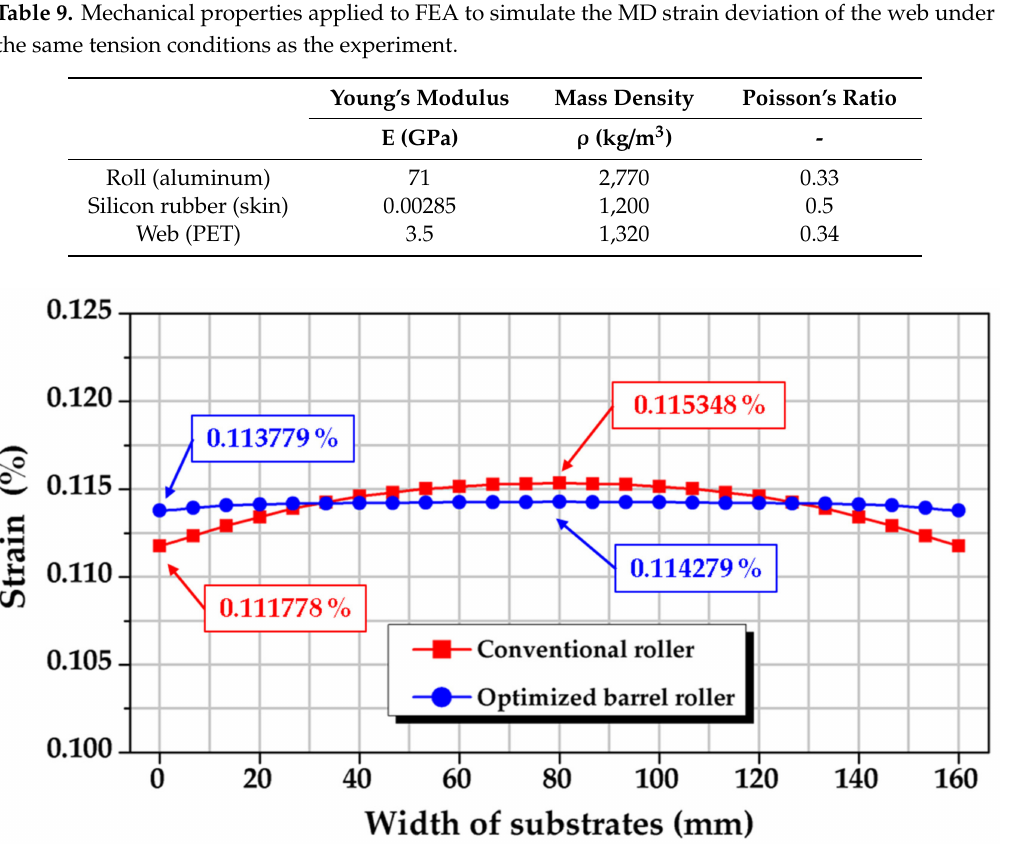
Figure 17. Comparison of FEA between the existing roller and barrel roller derived by calculating the MD strain distribution under 3 MPa of tension and then changing the tension to 5